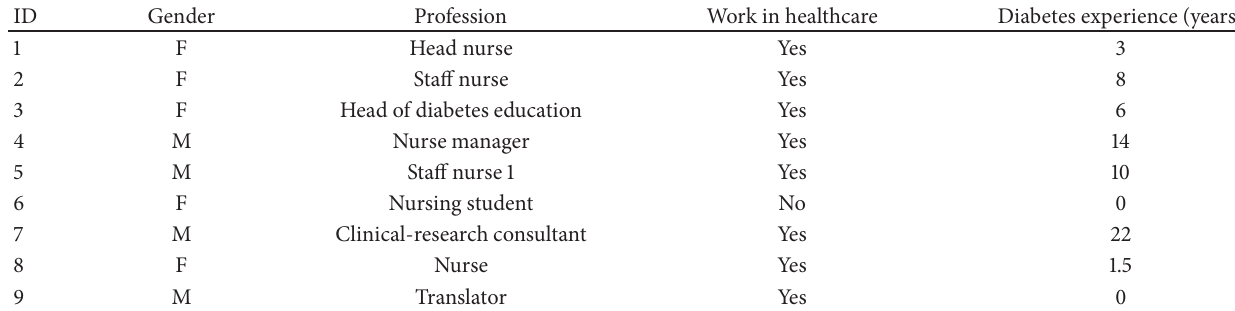
Table 1: Expert panel